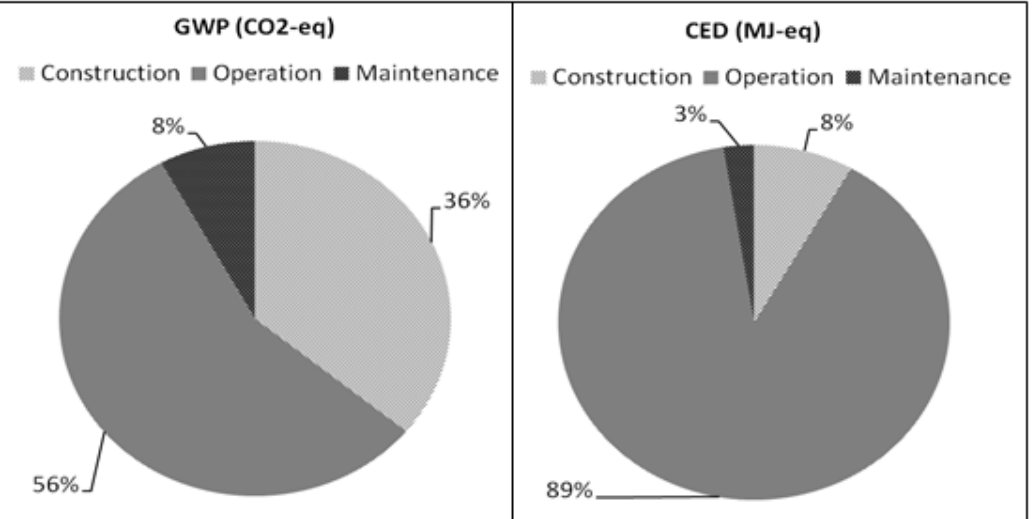
Figure 4. Share of Cumulative Energy Demand (CED) and CO 2 -eq emissions during the main life-cycle stages of Norra